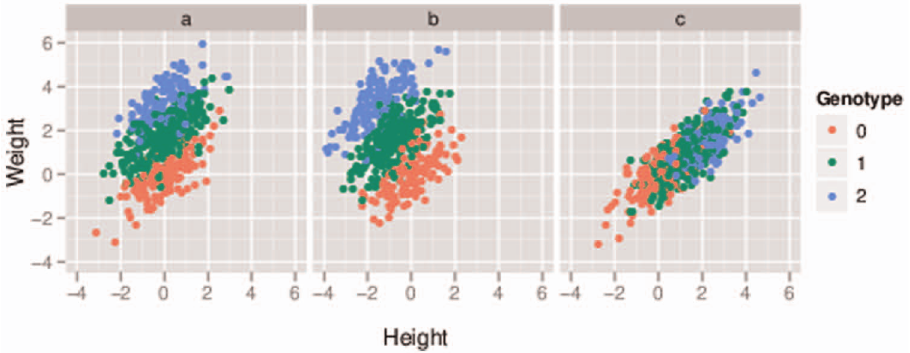
Figure 1. Illustration of three simple scenarios of association between genotype and a bivariate phenotype. All three scenarios involve positively-correlated bivariate response, which for concreteness we refer to as height ( x -axis) and weight ( y -axis). Each point represents an individual, colored according to their genotype (0, 1 or 2 copies of the minor allele). A) A variant associated with weight but not height . Even though height is unassociated, it nonetheless clearly helps to consider weight and height jointly in testing for association: the separation between genotype classes in the two-dimensional space is substantially greater than the separation along the y axis alone. In fact, here the most powerful analysis would be the test for association with weight , controlling for height . B) The minor allele decreases height but increases weight : it is an allele for being ‘‘short and fat’’. Here the three genotype classes are much better separated in the two-dimensional space, than for either phenotype individually. Should one be lucky enough to encounter such a genetic variant, a multivariate test would be considerably more powerful to detect it than either univariate test. C) Here the minor allele increases height , and as a result increases weight , resulting in what we will call an ‘‘indirect’’ association with weight . In this case the separation of the groups in the bivariate space is no greater than the separation along the x axis alone, and the most powerful analysis would be a univariate test for association with height . In all panels, the differences among genotype classes were deliberately made very large for clarity of